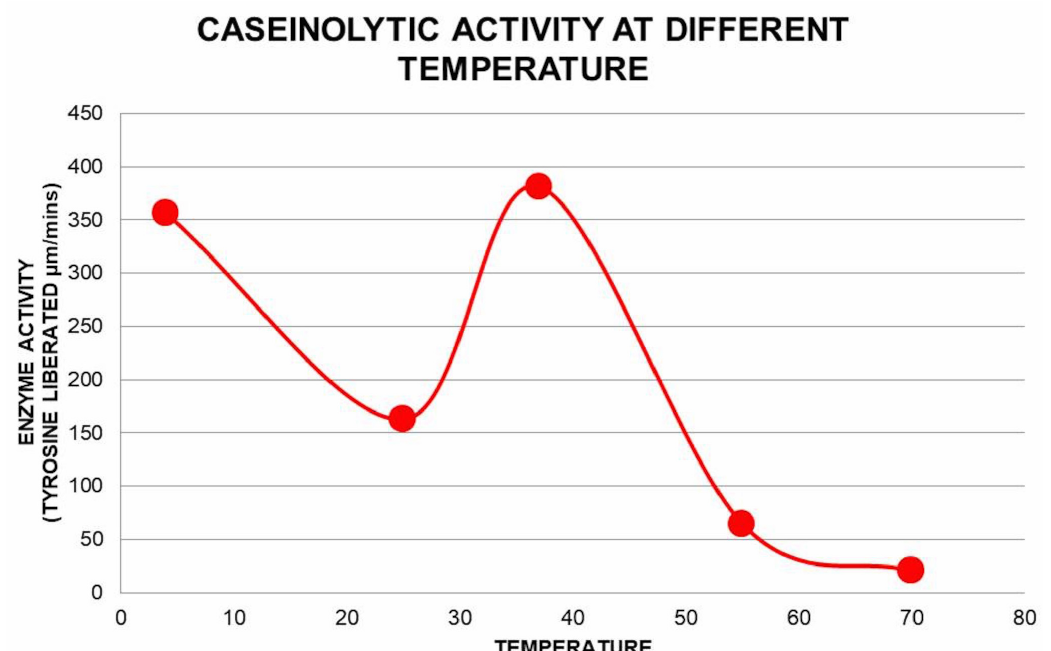
Figure 5. Effect of temperature on the caseinolytic property of the protease. Protease activity of the pooled pure fractions on β -casein degradation is plotted against different temperature (4, 25, 37, 55 and 70°C) at pH 8. Free tyrosine liberated due to β -casein degradation was measured as described